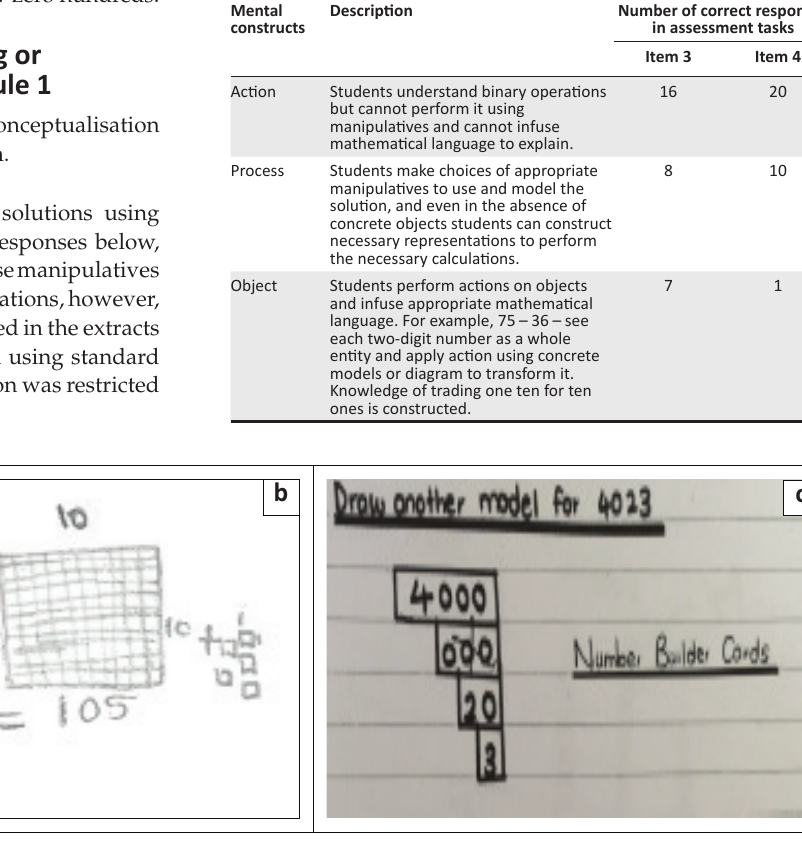
FIGURE 2: (a, b & c) Sample of students’ written responses to items 1 and 2.